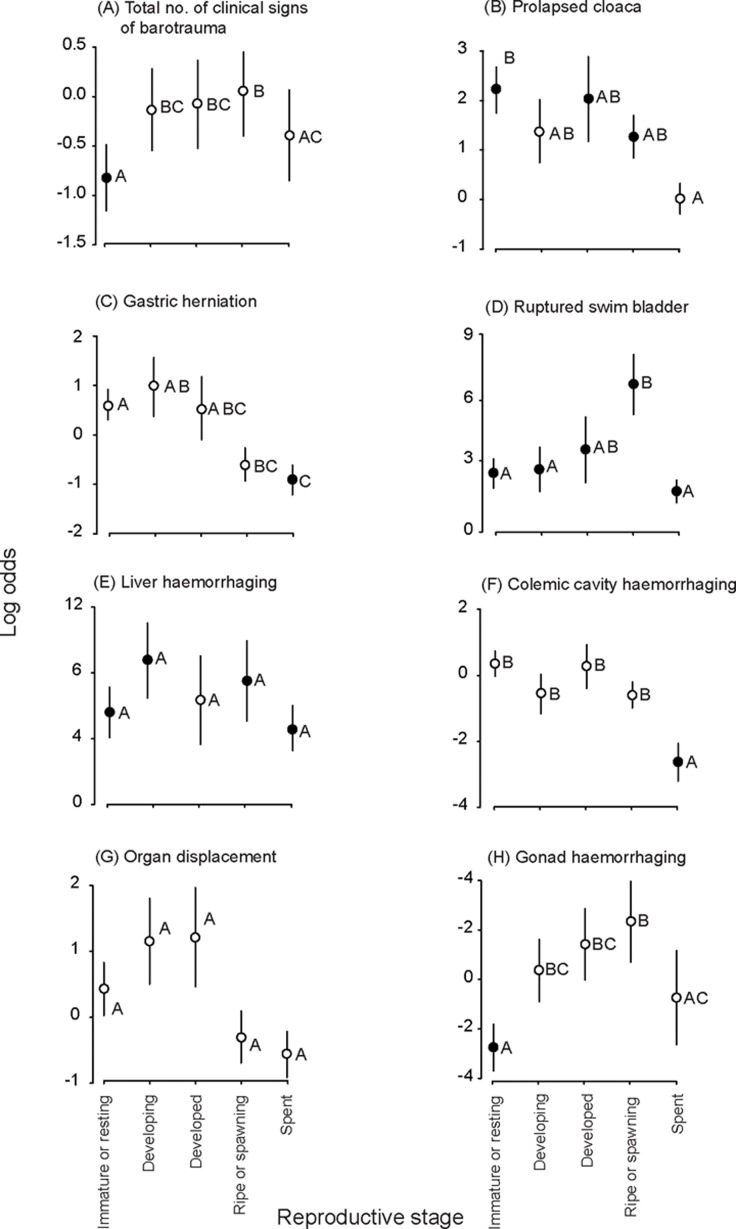
Log odds (± SE; standardized to mean depth) from logistic models across five reproductive stages of Chrysophrys auratus for (A) the total number of clinical signs of barotrauma, (B) prolapsed cloaca, (C) gastric herniation, (D) ruptured swim bladder, (E) liver haemorrhaging, (F) coelomic cavity haemorrhaging, (G) organ torsion and (H) gonad haemorrhaging.The significance of the log odds is designated by either black (p<0.05) or white (p>0.05) circles, while the dissimilar letters represent differences detected in false-discovery-rate pairwise comparisons (p<0.05).